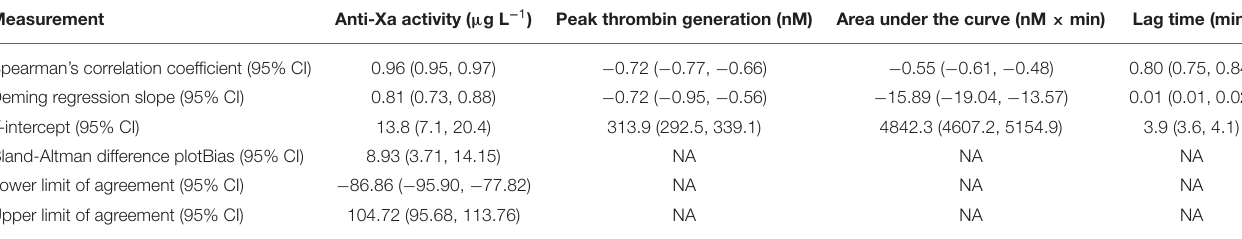
TABLE 2 | Accuracy of anti-Xa measurements and thrombin generation results with regard to drug concentration in 559 patients taking rivaroxaban, apixaban, or edoxaban in clinical practice.